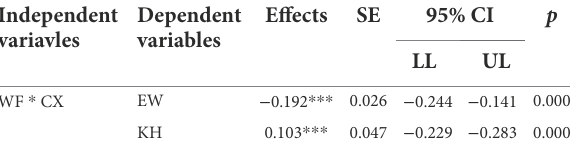
TABLE 5 Interactive effect. Independent